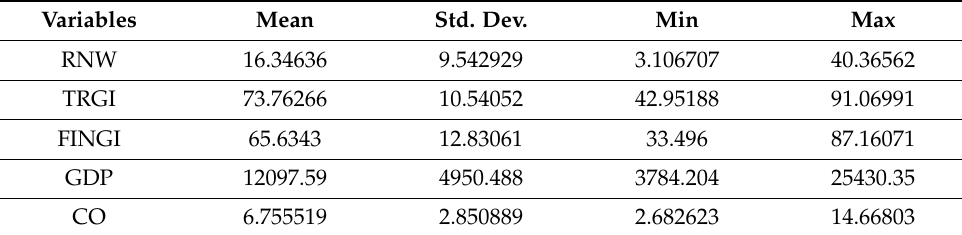
Table 3. Main characteristics of the